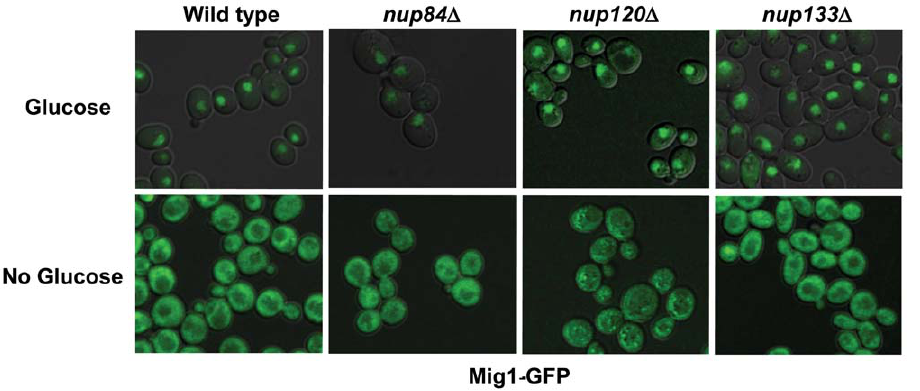
Figure 2. Nucleocytoplasmic shuttling of Mig1 occurs normally in the absence of NUP120 or NUP133 . Confocal images show localization of Mig1-GFP in either the presence (top panels) or absence (bottom panels) of glucose, in either wild type (WT) or mutant